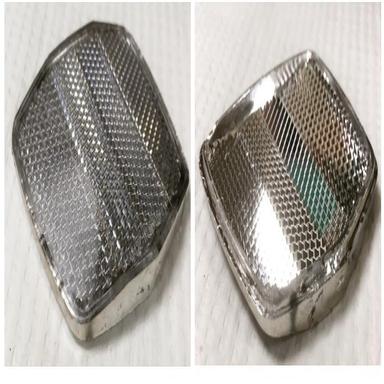
Near normal-hemispherical solar spectral reflectance of front of bicycle retroreflector (A) before and (B) after sputtering aluminum on its rear surface.